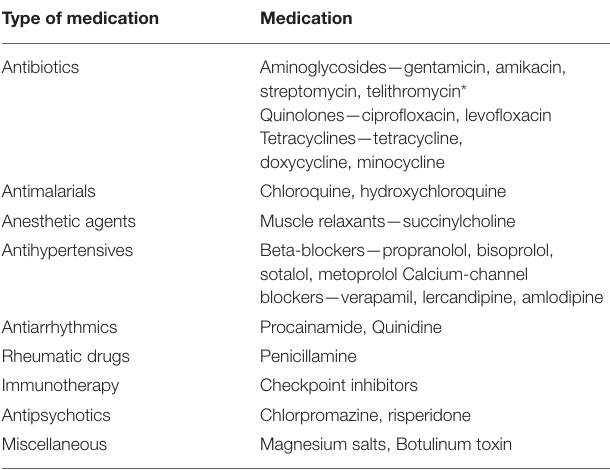
TABLE 1 | List of medications that may cause worsening of underlying myasthenia